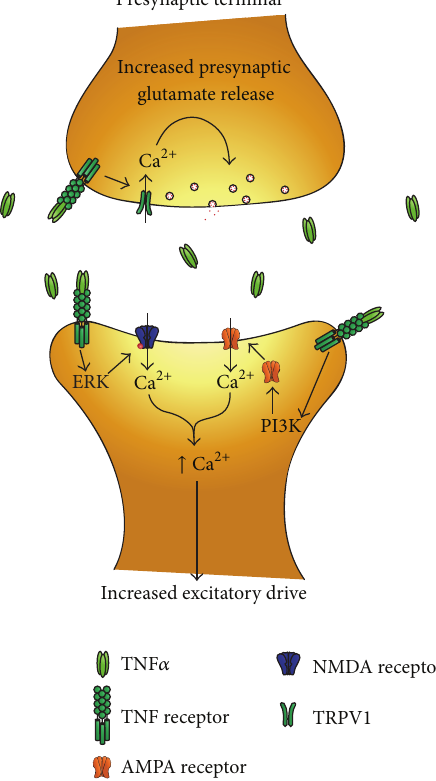
Figure 3: Schematic of TNF 𝛼 induced potentiation of spinal cord synaptic transmission. Microglial release of TNF 𝛼 increases excitatory neurotransmission in the dorsal horn via both presy- naptic and postsynaptic mechanisms. At presynaptic sites, TNF 𝛼 increases glutamate release via TRPV1 activation and there will be a subsequent increase in intracellular Ca 2+ . At postsynaptic sites, TNF 𝛼 increases the activity of AMPA and NMDA receptors via activation of PI3K and ERK on glutamatergic neurons to increase excitatory